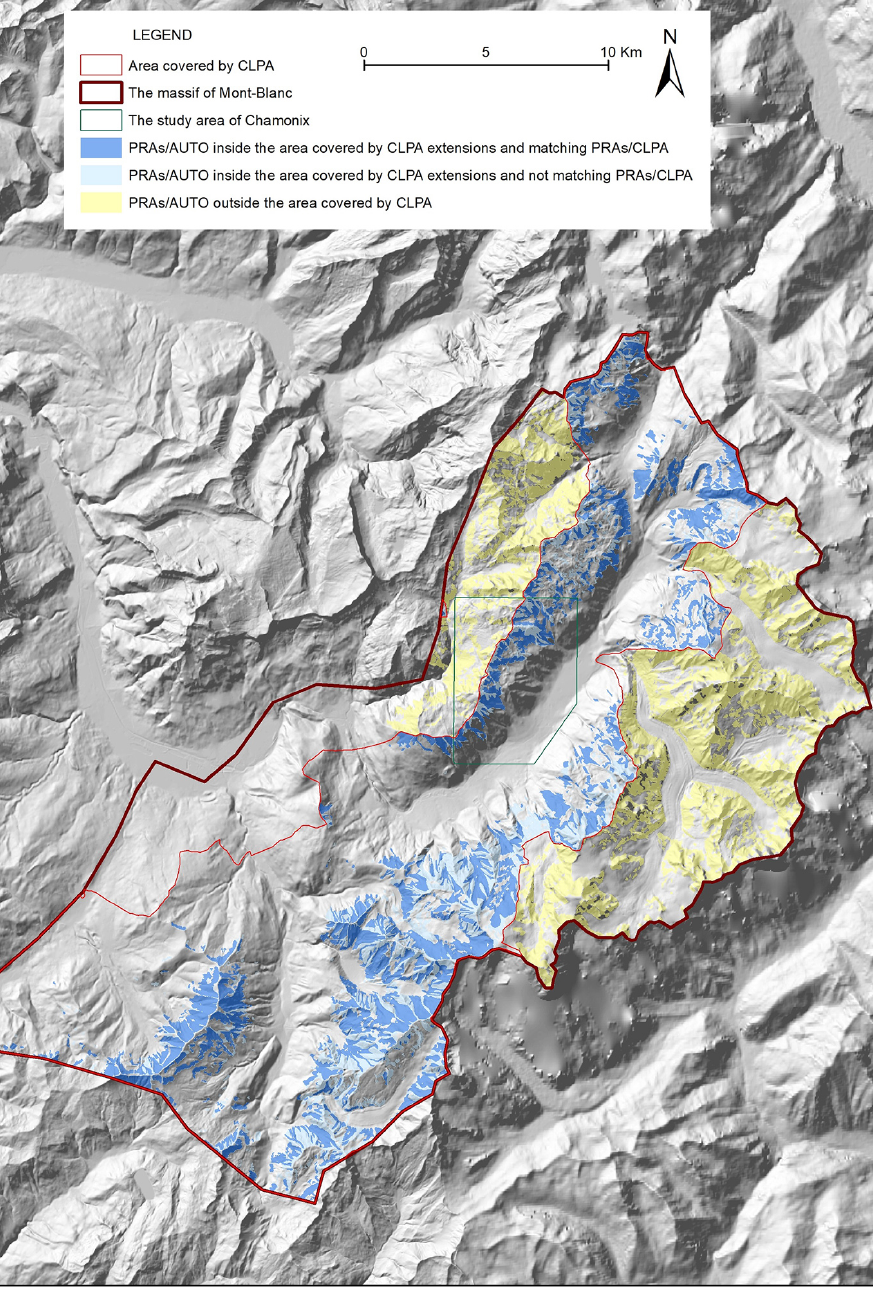
Figure 7. Result of the proposed PRA detection method for the entire Mont Blanc massif. Digital elevation model © IGN. For the PRA detection and the determination of the validation sample, all factors and the DEM resolution are set to their default values (Figs. 3–4), and forest cover data are from DB forest IGN. “CLPA extensions” refer to avalanche extents from the French avalanche